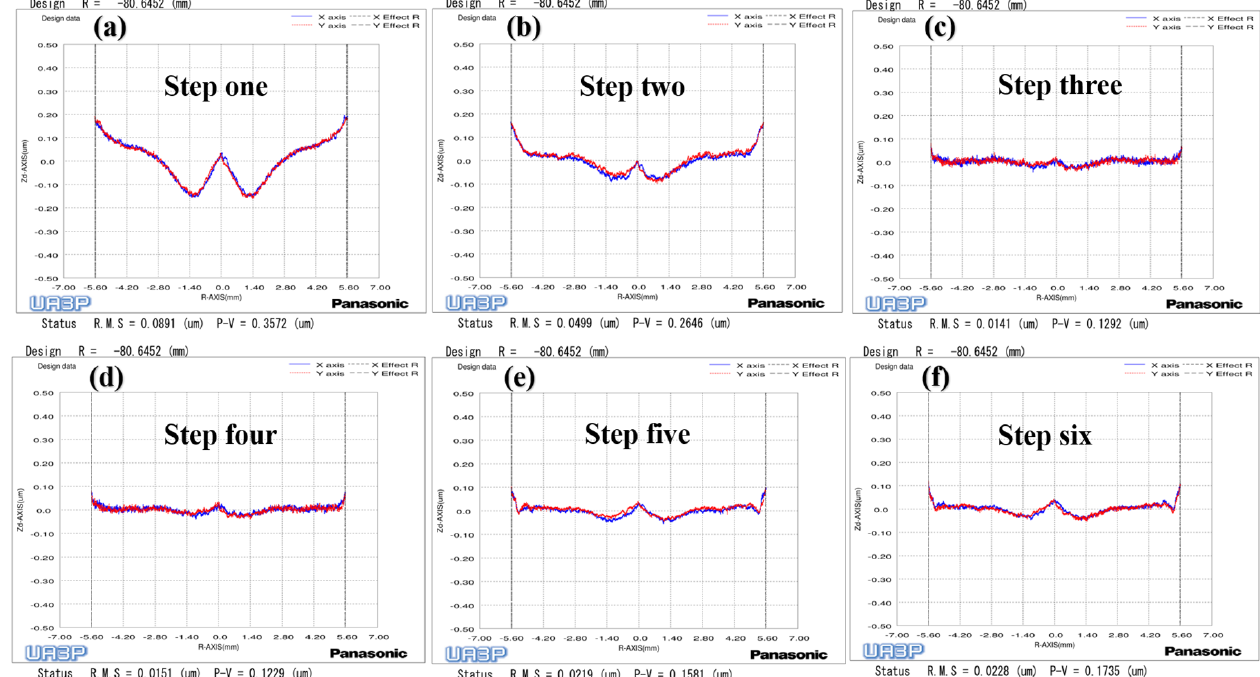
Figure 13. Surface shape change process of aspherical mold one: ( a ) Grinding; ( b ) The first polishing with constant rotation speed mode; ( c ) The second polishing with constant rotation speed mode; ( d ) Polishing with variable speed mode; ( e ) Polishing with small polishing disc tool; ( f ) Polishing with variable speed mode.